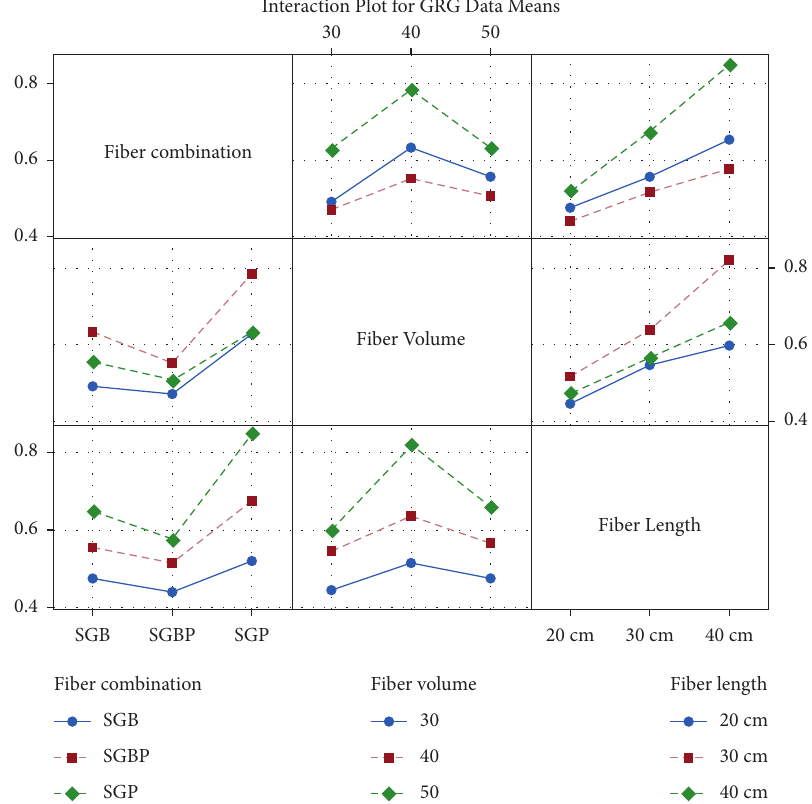
Figure 8: Graphical representation of the interaction effect plot on output response of different input